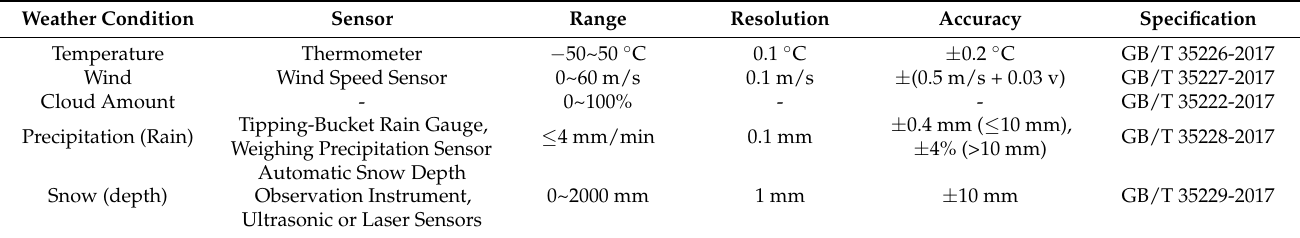
Table A6. Parameters and Specifications of the sensors to measure weather